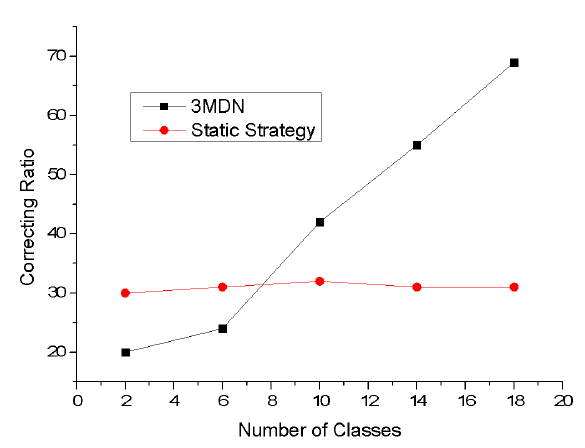
Fig. 5. Influence of SMGU on different models